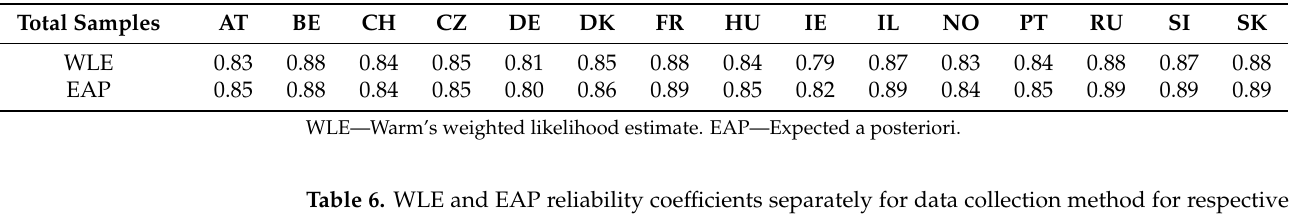
Table 5. WLE and EAP reliability coefficients for the individual countries independent of data collection method.